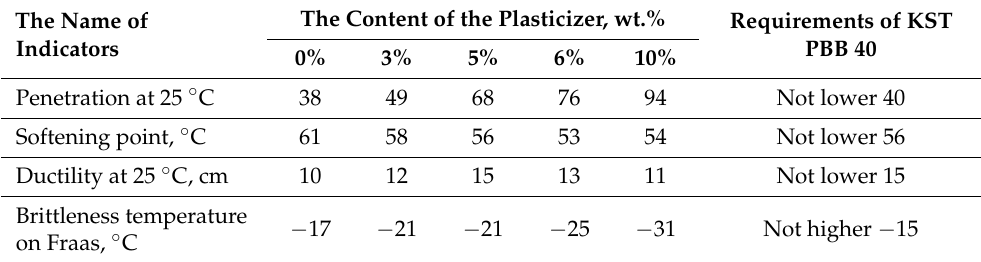
Table 5. Physical-mechanical characteristics of polymer-bitumen binders with a content of 3% PET polymer waste and the addition of